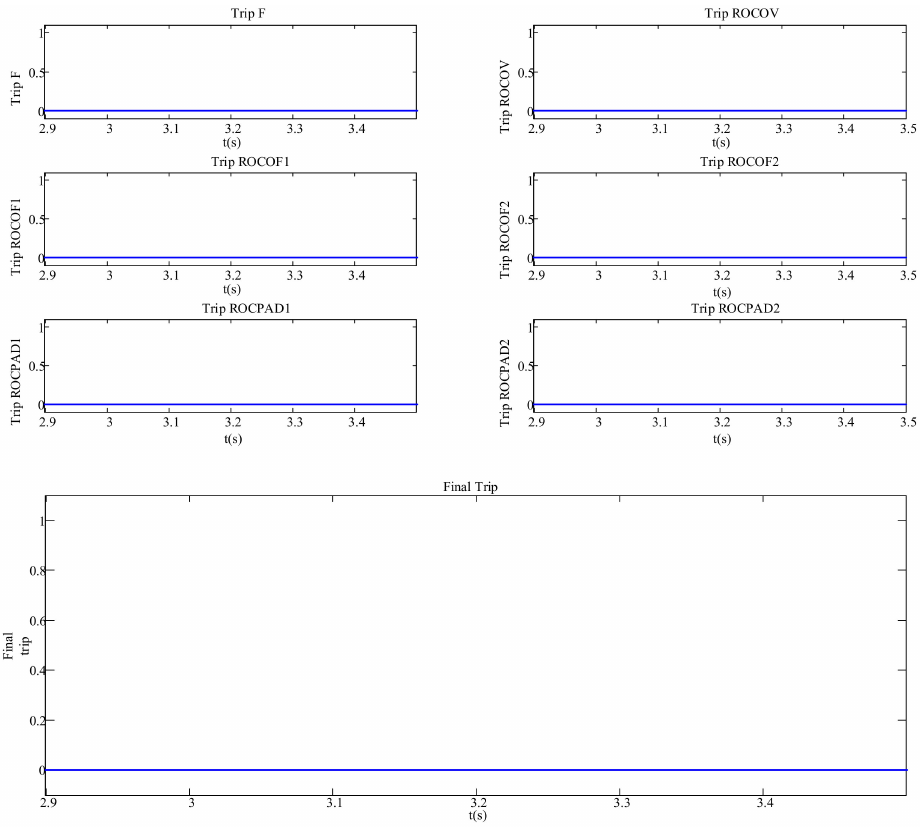
Figure 17. Trip signal of relays and the proposed algorithm in load